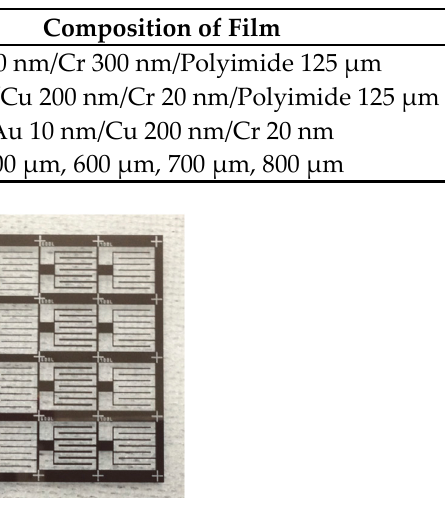
Table 1. Compositions of Cr and Cu film heaters.